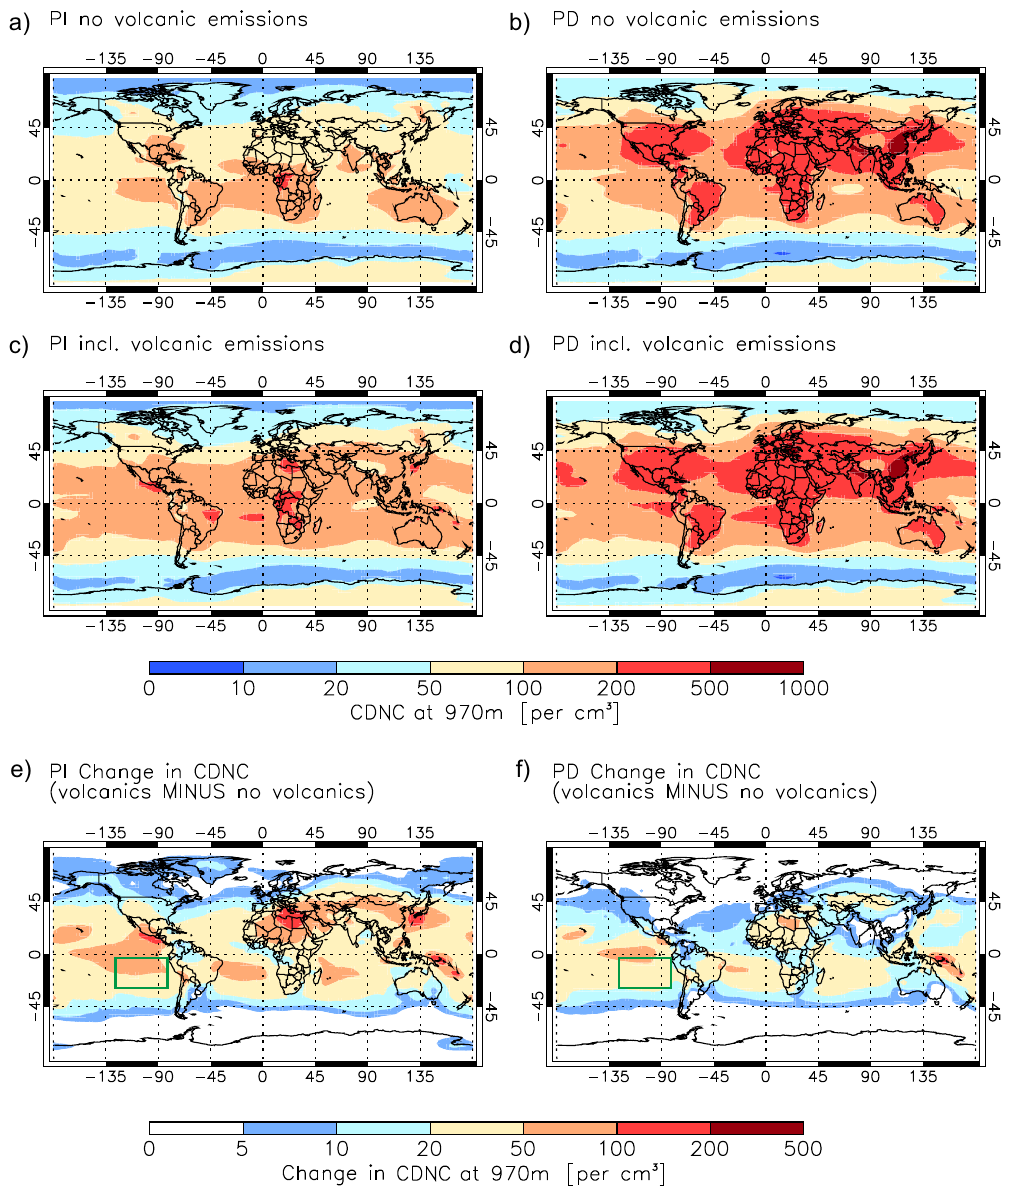
Fig. 6. Annual mean cloud droplet number concentrations (CDNC, cm − 3 ) at cloud-base altitude (approx. 970m above terrain or sea level) for (a) the pre-industrial (PI) era without volcanic emissions; (b) the present-day (PD) era without volcanic emissions; (c) PI era with volcanic emissions; and (d) PD era with volcanic emissions. The absolute difference in annual mean CDNC for the PI and PD eras are shown in panels (e) and (f) , respectively. The green box to the west of South America covers the area between 82 ◦ W–132 ◦ W longitude and 4 ◦ S–29 ◦ S latitude (see Sect.